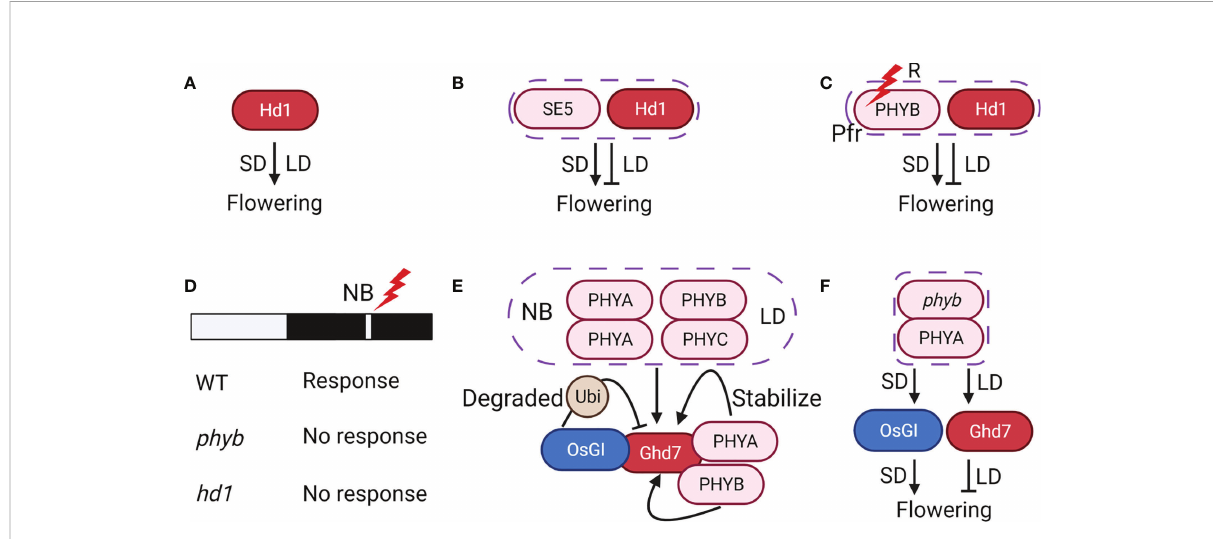
FIGURE 4 A strong connection exists between the reversal mechanism and phytochromes. (A) Hd1 alone is a fl owering activator. (B) Hd1 changes to be a fl owering suppressor with SE5 in LD. (C) Hd1 changes to be a fl owering suppressor with PhyB in LD. (D) PhyB and Hd1 are critical to NB response. (E) Phytochromes, NB and LD regulate Ghd7 positively. OsGI degrades Ghd7 through the ubiquitination mechanism. (F) PhyA promotes the expression of OsGI under SD and Ghd7 under LD in phyb background. PhyA induces fl owering under SD but represses it under LD without PhyB. Arrows represent positive regulation, inhibitors represent negative regulation, and graphical overlap represents protein physical